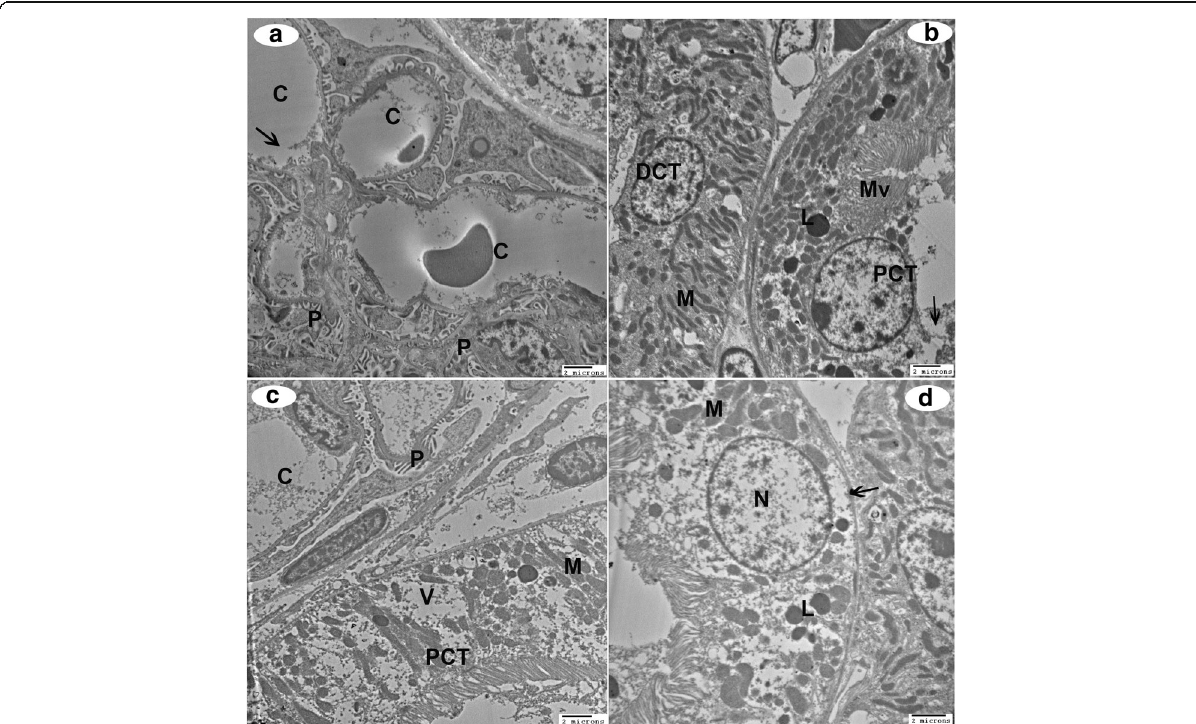
Fig. 5 Electron micrographs of the rat cortex of KT/WR group. a The glomerular podocyte with hypertrophic processes (P), dilated blood capillaries (c), and damaged plasma membranes (arrow). b Lining cells of PCT and DCT appeared with varying degrees of vacuolation and fragmentation, microvilli (Mv), mitochondria (M), lysosomes (L), and damaged plasma membrane (arrow). c PCT with severe vacuolated cells (V) and damaged mitochondria (M), and glomerulus with dilated blood capillary (C) and stretched electron dense podocytic processes (P). d Higher magnification of PCT with vacuolated nucleus (N), damaged disorganized mitochondria (M), many lysosomes (L), and fragmented basal enfolding (arrow) (scale bar = 2 μ